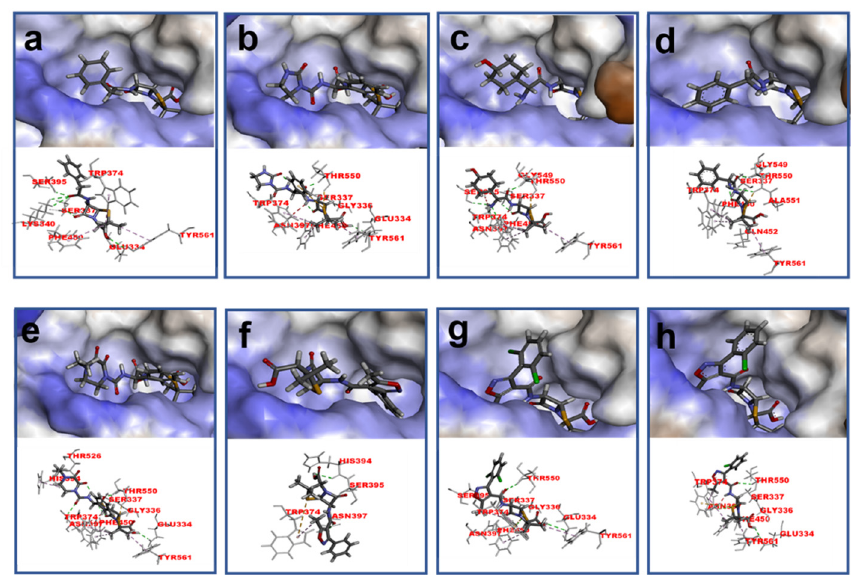
Figure 4. Schematic representation of the interactions between PBP2x* (PDB code: 2z2m) and ( a ) PNG; ( b ) AZL; ( c ) AMX; ( d ) AMP; ( e ) PIPC; ( f ) OXA; ( g ) DCX; and ( h ) CLX. Hydrogen bonds are shown as green dashed lines, and hydrophobic interactions are displayed as purple dashes.